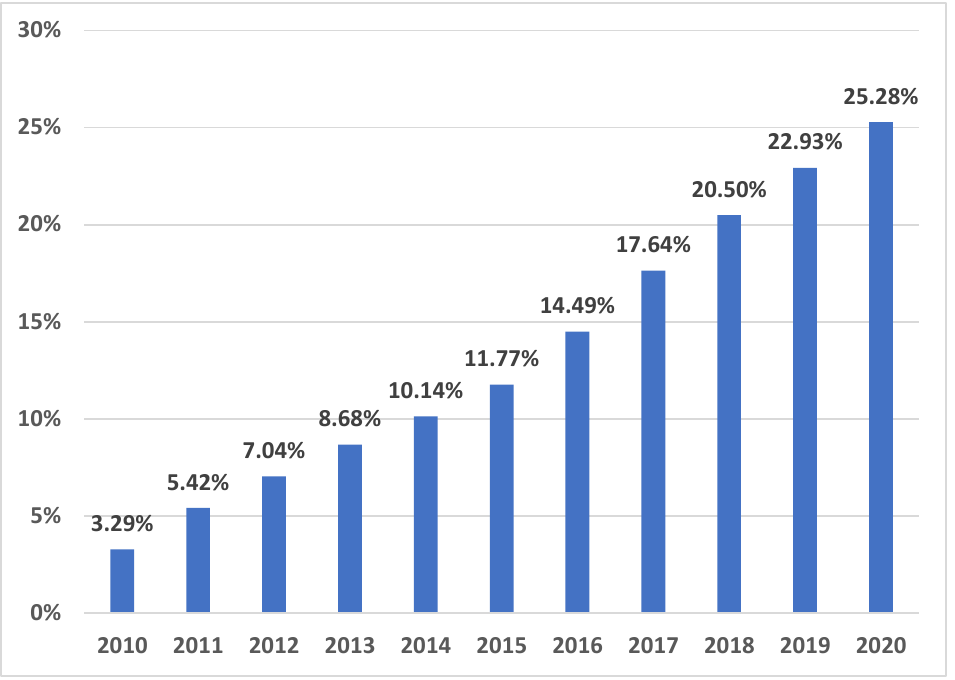
Figure 1. Percentage of solar PV contribution to worldwide MW capacity in the last decade [3].